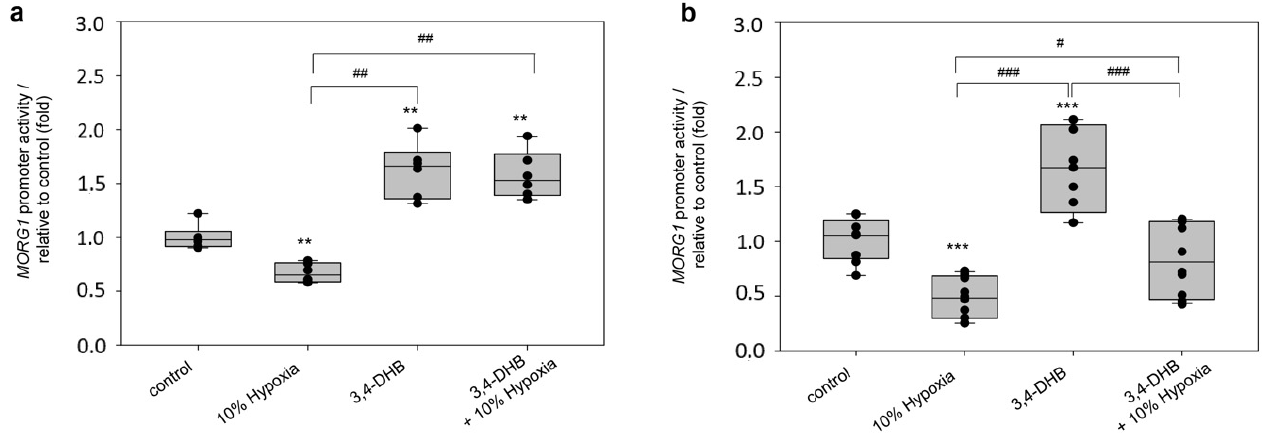
Figure 8. Application of 3,4-DHB reversed the hypoxia inhibitory effect on the MORG1 promoter reporter activity at an early time point. HEK 293 cells were transiently transfected with the wild-type MORG1 promoter construct and were left untreated (control) or treated with 500 µ M 3,4-DHB or expose to 10% hypoxic conditions. To check the ability of 3,4-DHB to reverse the inhibitory effect of hypoxia on MORG1 promoter activity in parallel experiments in addition to 10% hypoxia treatments was added as well 500 µM 3,4-DHB for different time periods and the promoter reported activity was assayed. ( a ). Relative MORG1 promoter reporter activity at 6 h treatment of control, 10% hypoxia, 3,4-DHB and 10% hypoxia + 3,4-DHB. N = 6/6/6/6. ** p < 0.01 vs. control. ## p < 0.01 vs. 10% hypoxia. ( b ). Relative MORG1 promoter reporter activity in 12 h treated HEK 293 cells of control, 10% hypoxia, 3,4-DHB and 10% hypoxia + 3,4 DHB. N = 9/12/9/12 . *** p < 0.01 vs. control. ### p < 0.001 vs. 10% hypoxia. # p < 0.05 vs. 10% hypoxia.